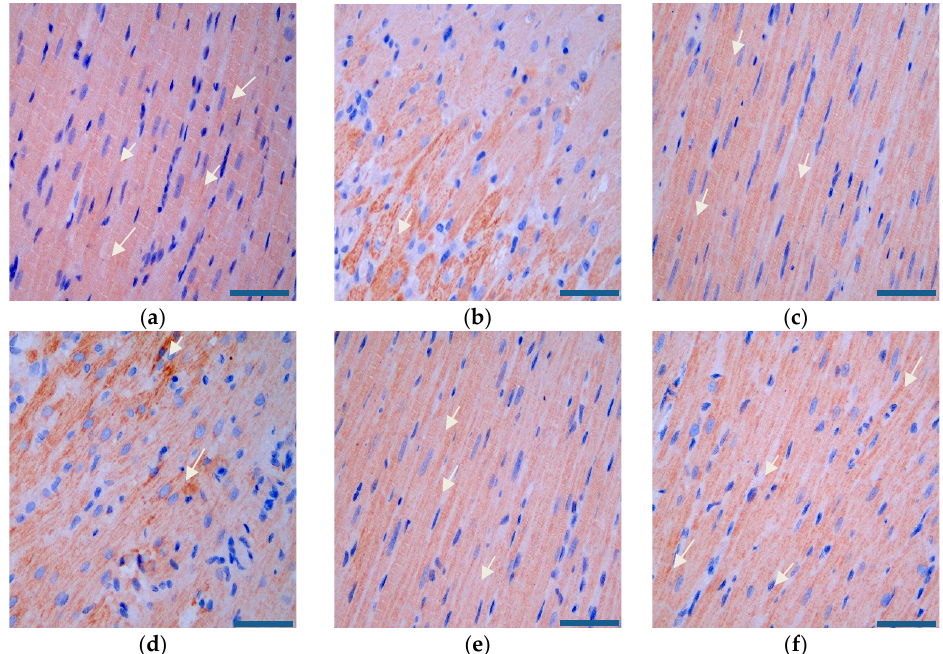
Figure 15. SIRT3 expression in the rat heart tissues (×400, scale bar = 200 μ m) of ( a ) the sham group, ( b ) the model group, ( c ) the positive drug group, ( d ) the miR-133 group, ( e ) the PEG-PLA/miR-133 group, and ( f ) the RGD-PEG-PLA/miR-133 group. Blue: nucleus, brown: SIRT3-positive stain. White arrows indicate the regions of strongly positive SIRT3 expression.